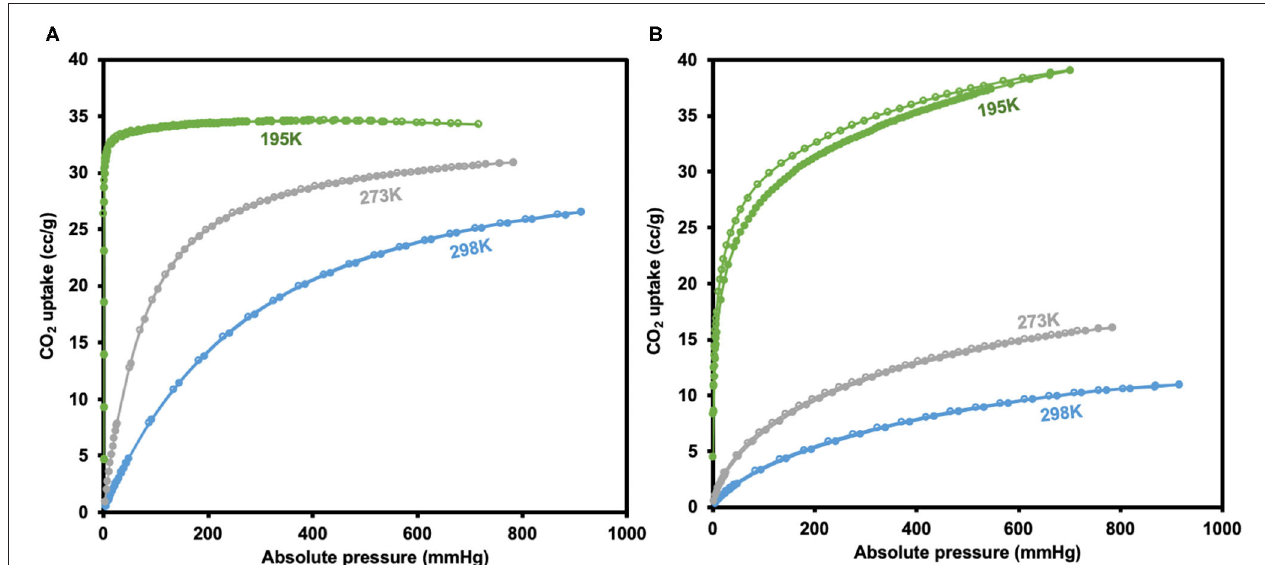
FIGURE 10 | CO 2 adsorption-desorption isotherms for JMS-3a (A) and JMS-4a (B) (closed circles represent adsorption and open circles desorption).